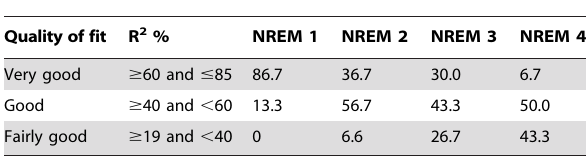
Table 2. Percentage of NREM episodes in each quality of fit category.